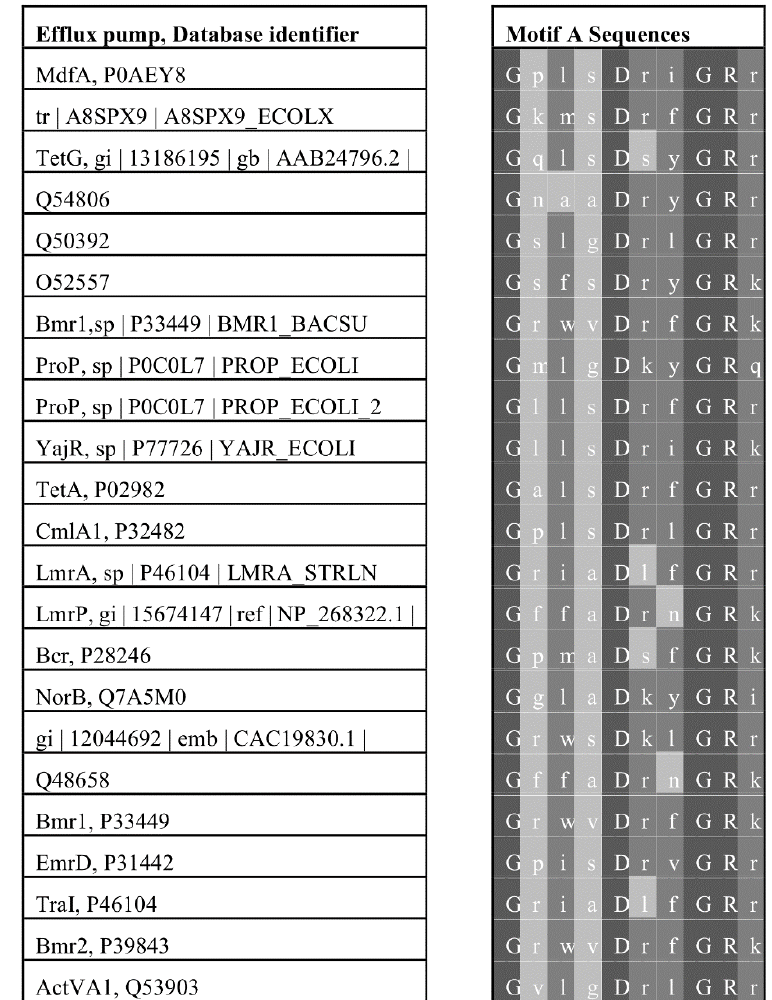
Figure 2. Multiple sequence alignment of motif A of efflux pumps of the major facilitator superfamily. This alignment shows the amino acid residues (right) of the highly conserved motif A of the major facilitator superfamily. This motif lies in the cytoplasmic loop between helices 2 and 3 of the MFS transporters indicated and their respective sequence database identifiers [9,94,98].